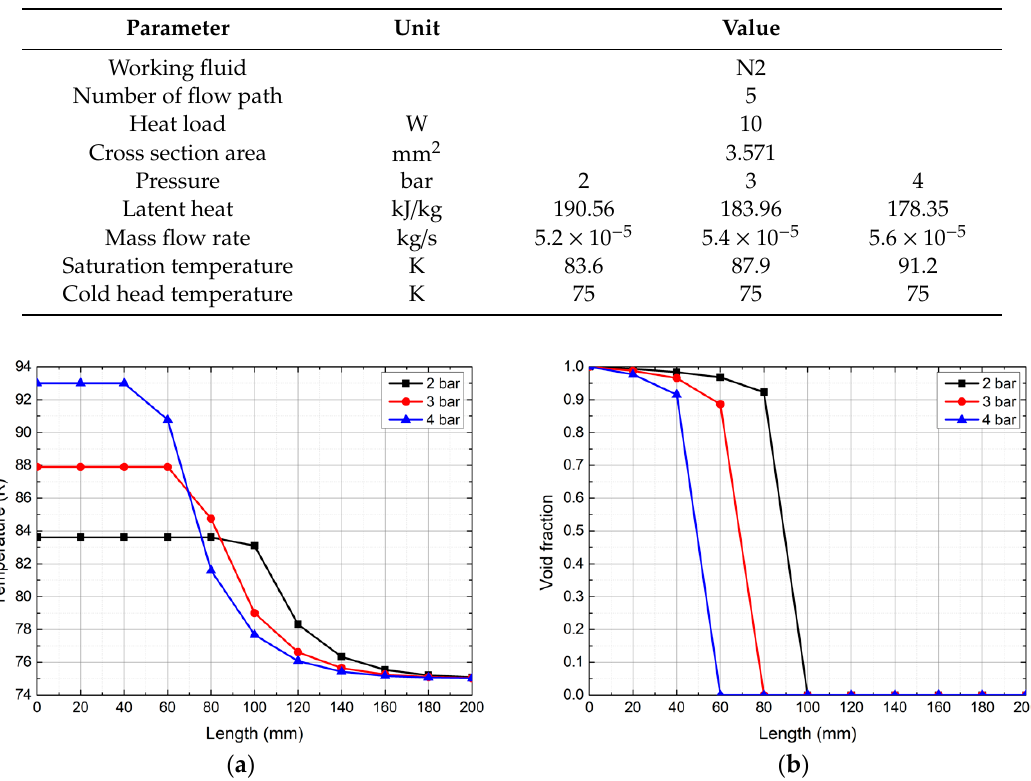
Figure 3. 1D-node network simulation analysis result: ( a ) temperature change of working fluid for cooling flow path length; ( b ) void fraction of working fluid for cooling flow path length.